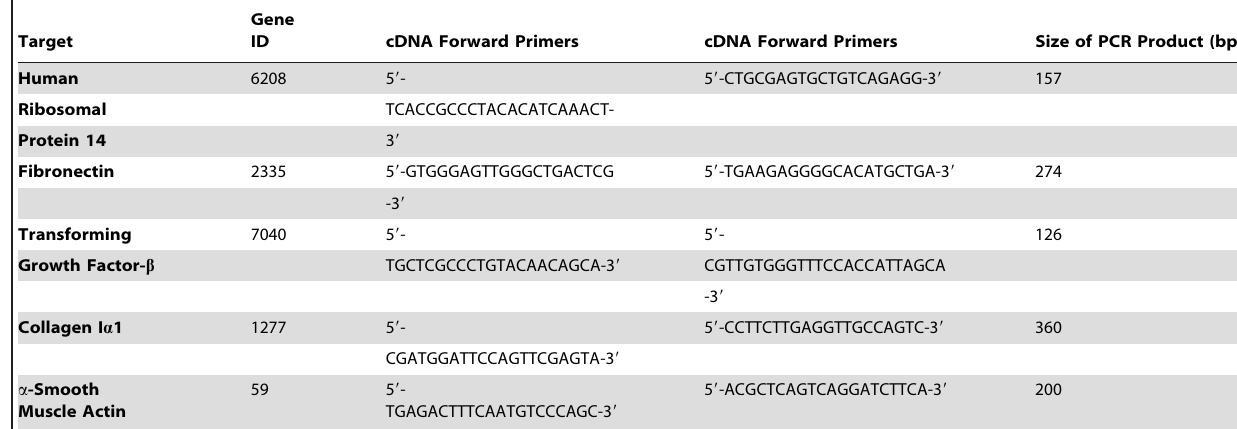
Table 1. Primer sequences and product sizes for